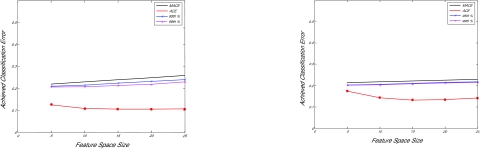
PACE analysis using a SVM-based classifier using the t-test scoring criterion, with a 0.6 MAC threshold. Left Panel: performance without peak selection. Right panel: performance with peak selection.